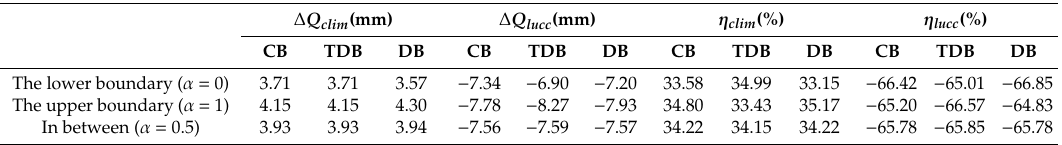
Table 3. The impacts of climate change and LUCC as well as contribution rates calculated by the complementary Budyko (CB), total differential Budyko (TDB) and present decomposition Budyko (DB) models for three cases of α = 0 for the lower boundary, α = 1 for the upper boundary, and α = 0.5 in between.